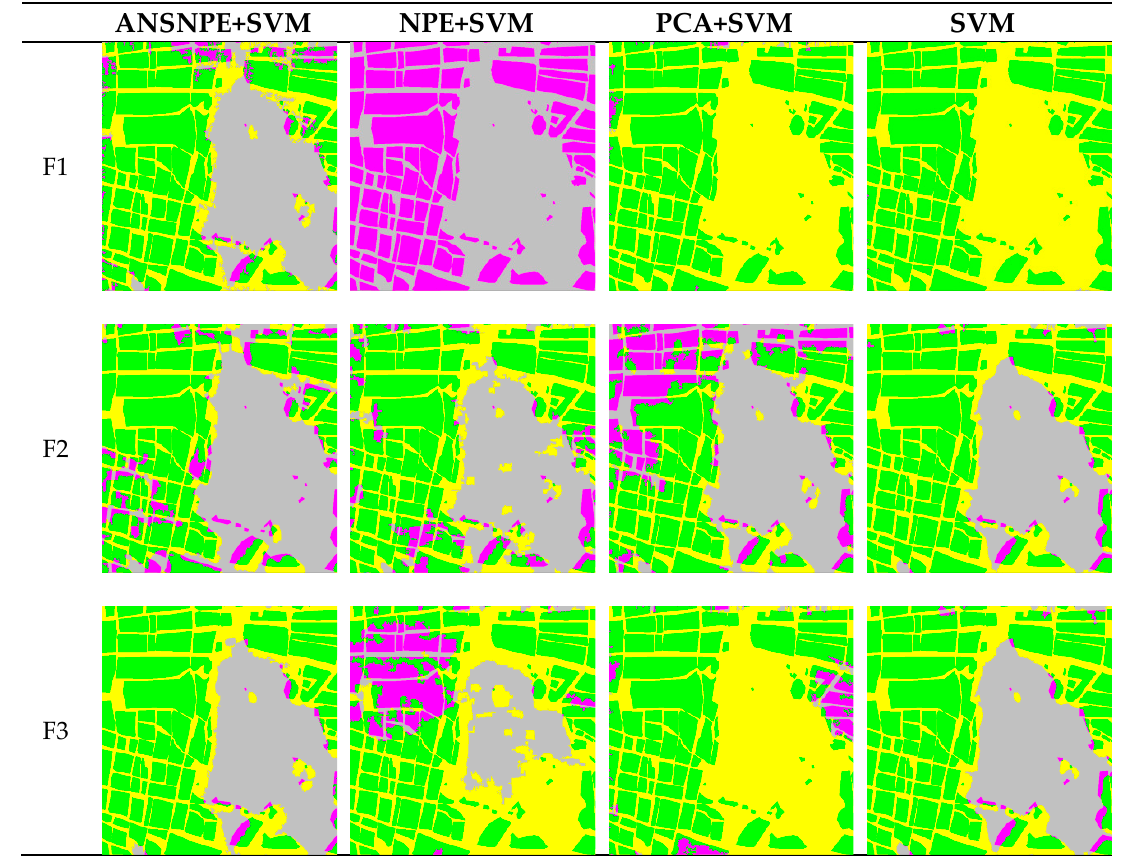
Figure 5. Classification results of three feature sets. Yellow means incorrect building areas, which are extracted; green shows the properly extracted building areas; red shows the building areas not being extracted; and gray shows the non-built areas. Table 5. Extraction accuracy of the three feature sets.